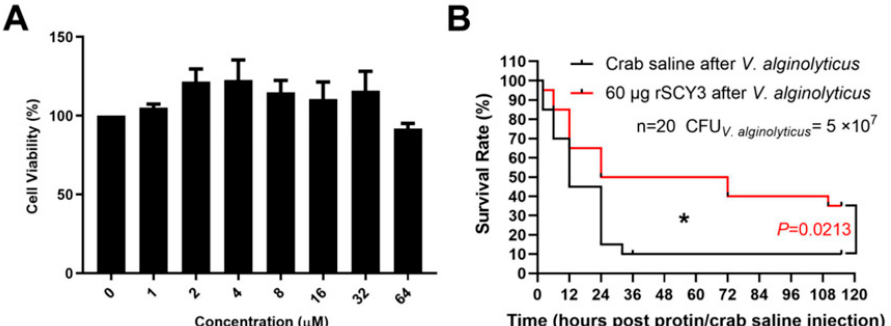
Figure 4. Evaluation of in vitro cytotoxicity and in vivo protective effect of rSCY3 on S. paramamosain infected by V. alginolyticus . ( A ) Cytotoxicity effect of recombinant protein rSCY3 on hemocytes isolated from male crabs. ( B ) In vivo protective effect of rSCY3. Crabs were challenged with V. alginolyticus at 5 × 10 7 CFU, and injected with 60 µ g rSCY3 at 1 h after bacterial challenging (n = 20 for each group). The survival curve of each group was analyzed using the Kaplan–Meier log-rank test. The asterisk indicated a significant difference compared with the control group (* p < 0.05).